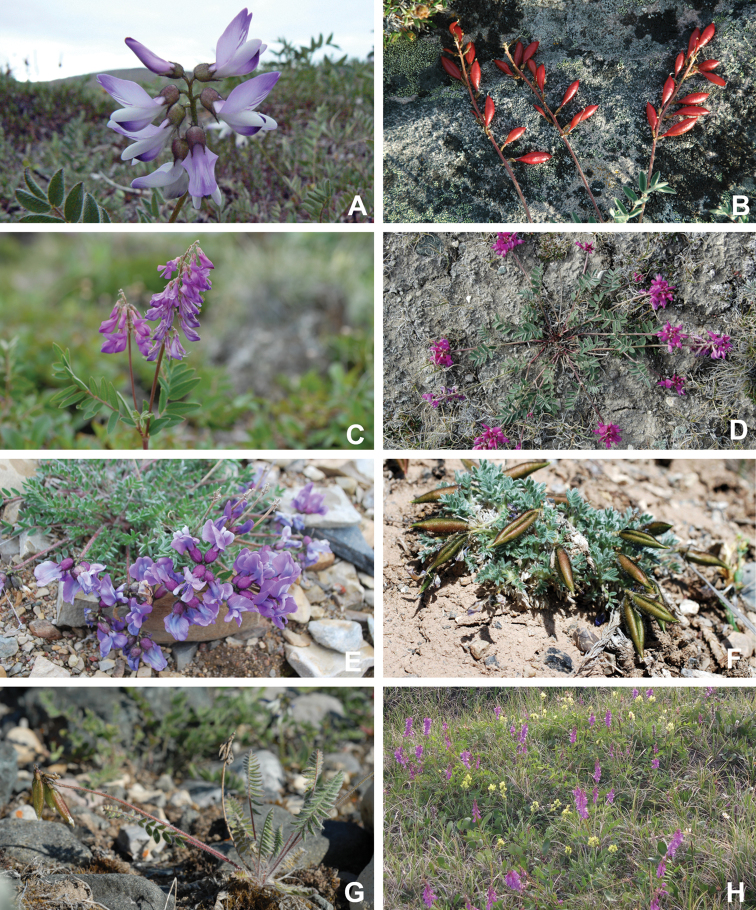
AAstragalus
alpinus inflorescence, Ulukhaktok, NT, 8 July 2010 BAstragalus
richardsonii infructescences, Johansen Bay, NU, 14 July 2008 CHedysarum
americanum inflorescence, Johansen Bay, NU, 18 July 2008 DHedysarum
boreale
subsp.
mackenziei habit, Kuujjua River, NT, 16 July 2010 EOxytropis
arctica
var.
arctica habit FOxytropis
arctobia habit, Gillespie et al. 9593GOxytropis
deflexa
var.
foliolosa habit, Gillespie et al. 10129HOxytropis
maydelliana habitat, Johansen Bay, NU, 15 July 2008. Photos A by P.C. Sokoloff B, D by R.D. Bull C, G, H by L.J. Gillespie E by B.A. Bennett and F by J.M. Saarela.